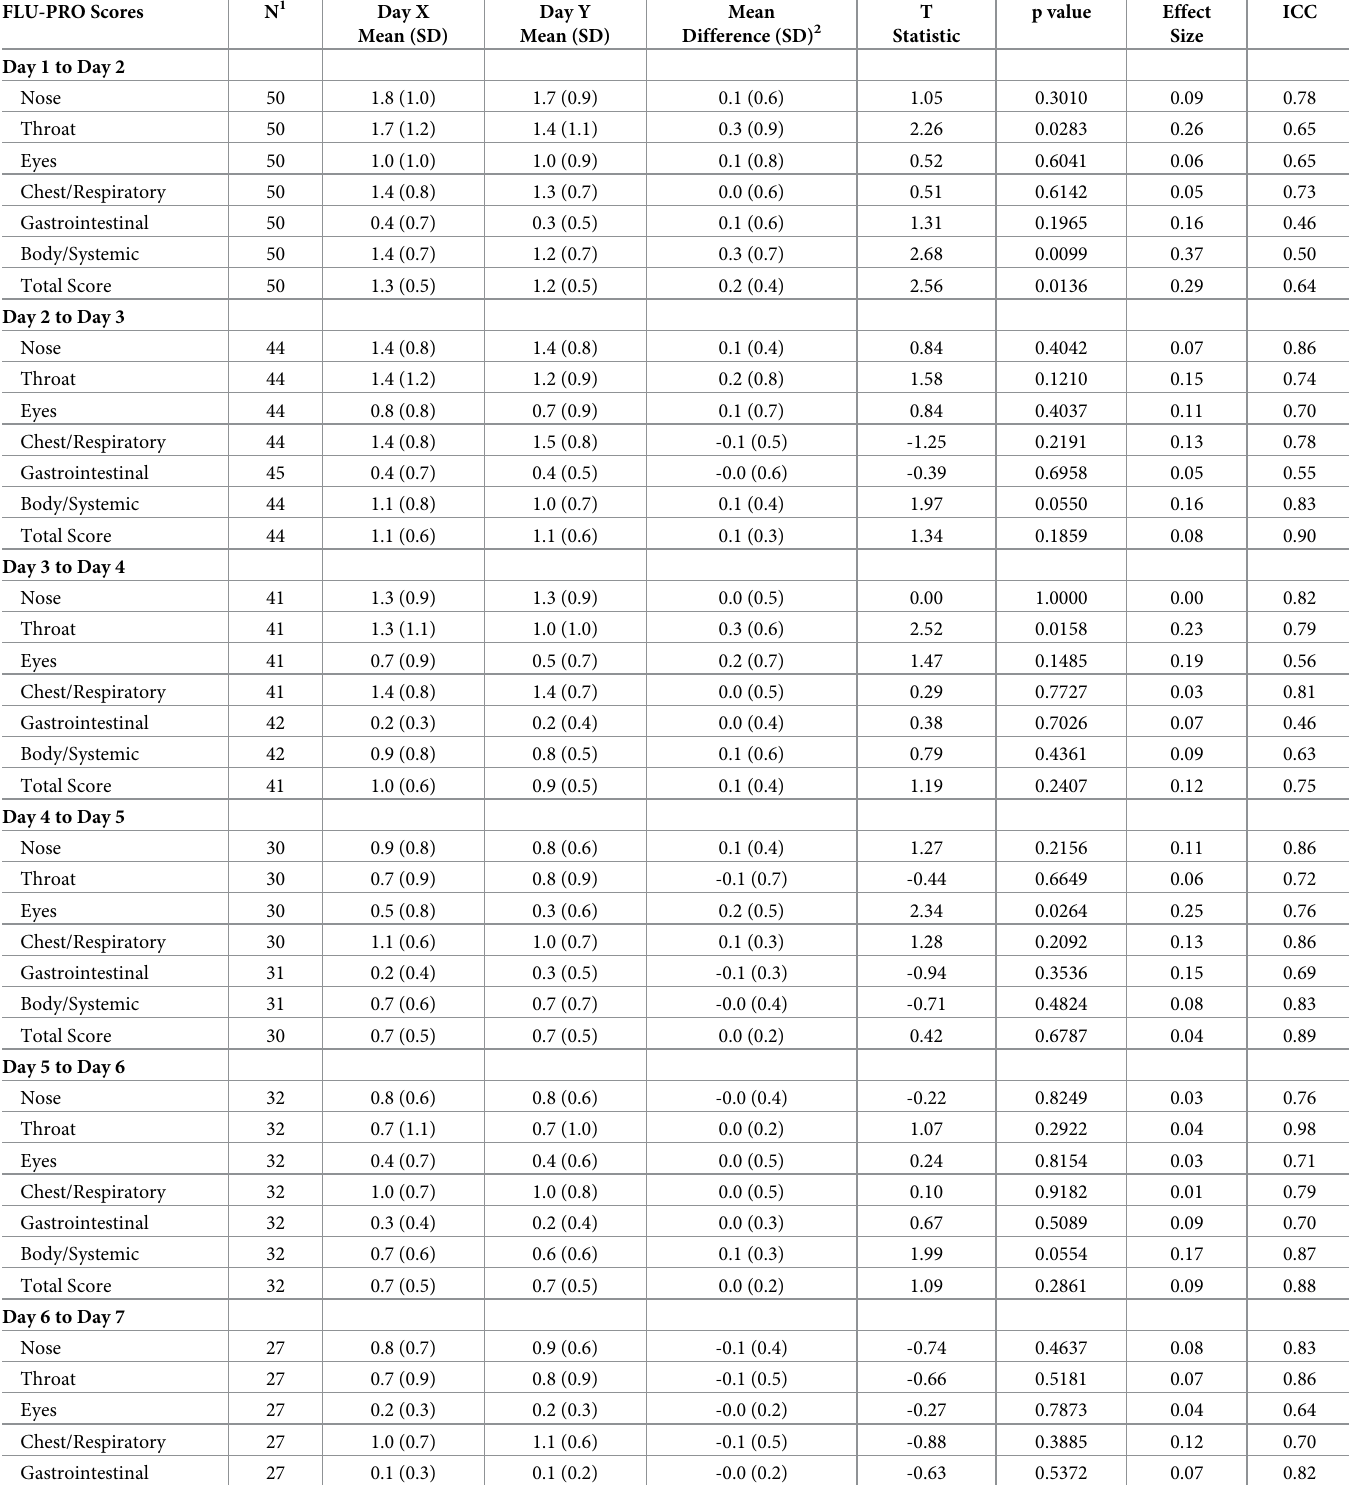
Table 3. Two-day test-retest reliability of FLU-PRO scores during Week 1 (Days 1 to Day